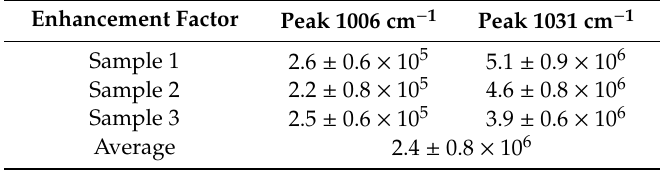
Table 1. All the measured EFs calculated from the spectra in Figure 6 ( a ) and reported in Figure 6 ( b ) are resumed in Table 1 for the Raman peaks at 1006 and 1031 cm − 1